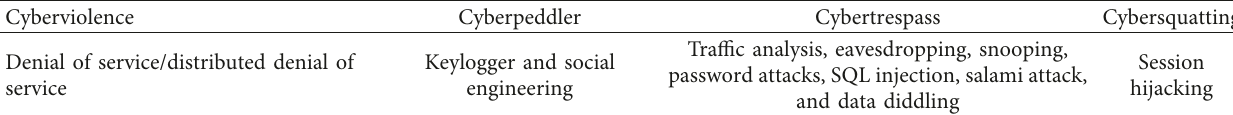
Table 2: Classification of cyberattacks on the basis of